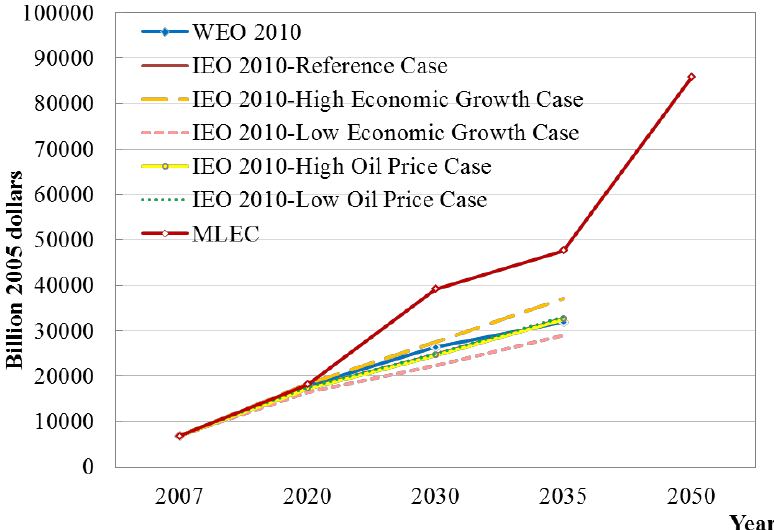
Figure 10. GDP growth setting in all scenarios of projected energy consumption of China.